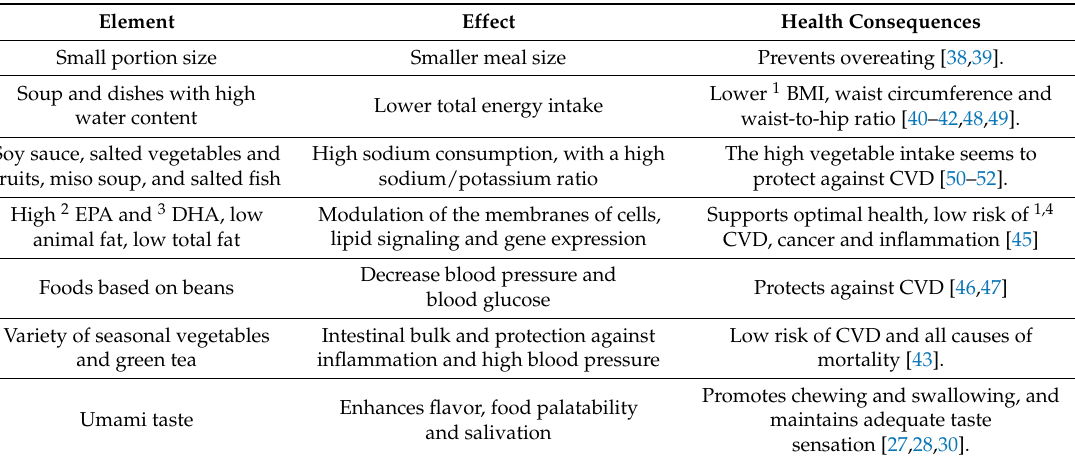
Table 3. Potential health traits of